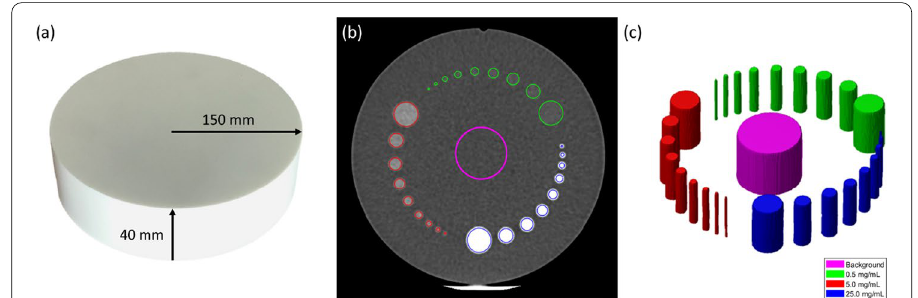
Fig. 1 a Image of the calibration phantom overlaid with physical dimensions. b Axial CT slice [ HU] of the calibration phantom with segmented structures for a background region (magenta) and three microsphere concentrations: 0.5 mg/mL (green), 5.0 mg/mL (red), and 25.0 mg/mL (blue). c Segmented structures in the calibration